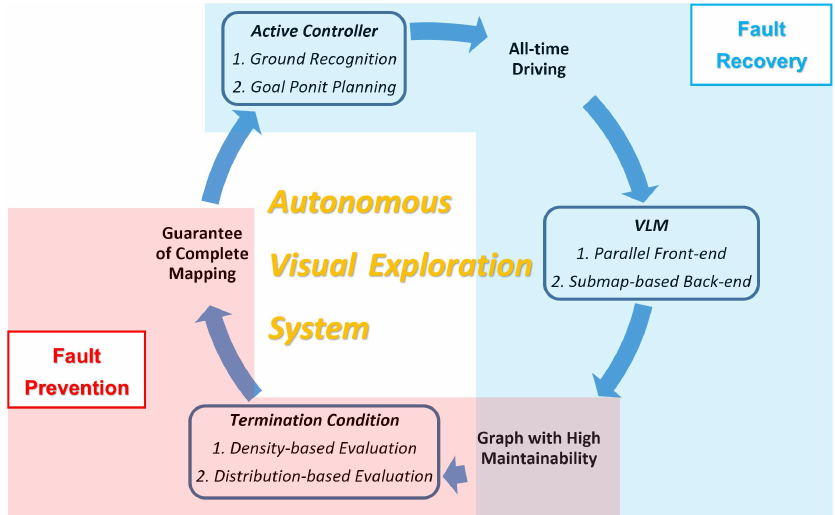
Figure 1. Structure of our visual exploration system, three modules are contained: visual localization and mapping (VLM), active controller and termination condition.